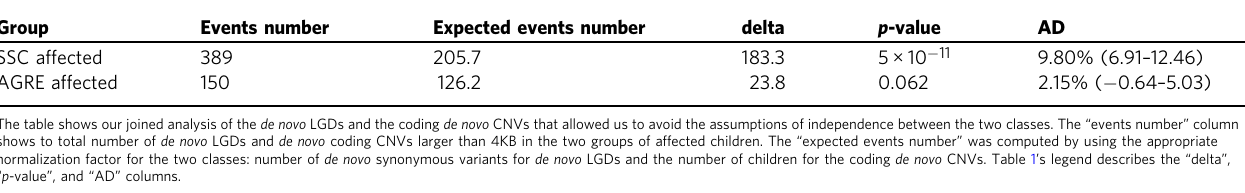
normalization factor for the two classes: number of de novo synonymous variants for de novo LGDs and the number of children for the coding de novo CNVs. Table 1 ’ s legend describes the “ delta ” , “ p -value ” , and “ AD ”